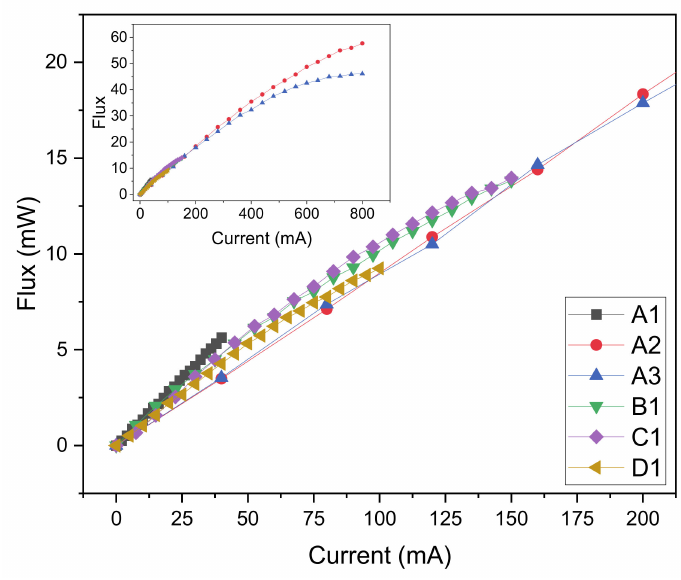
Figure 3. Optical flux as a function of current for the selected